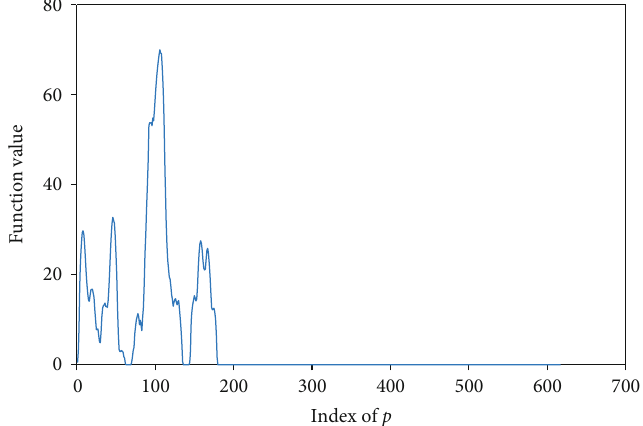
Figure 6: Results of the shift alignment